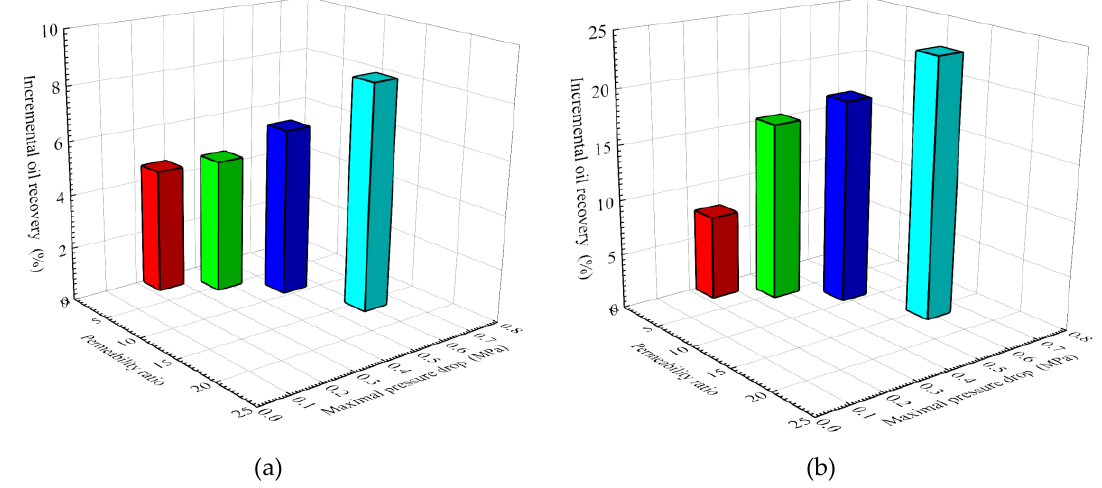
Figure 10. Effect of permeability ratio and maximal pressure drop on incremental oil recovery: ( a ) high-permeability cores; ( b ) low-permeability cores.